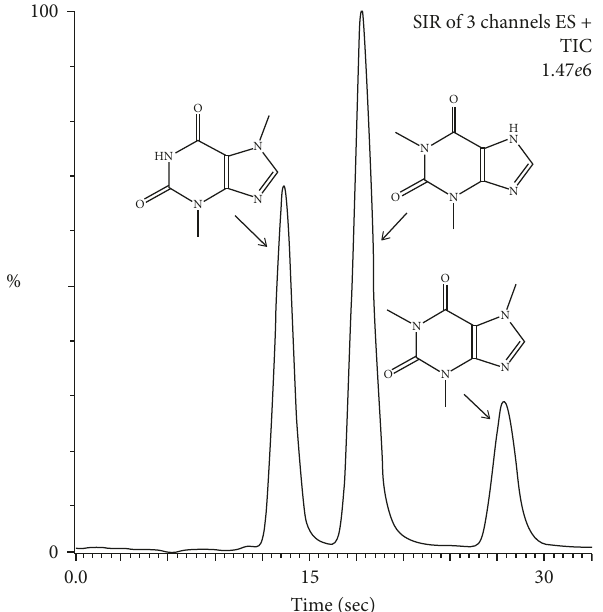
Figure 1: Chemical structures and chromatogram of the 1.0 μ g/mL theobromine, theophylline, and caffeine mixed standard solution at the optimized conditions.